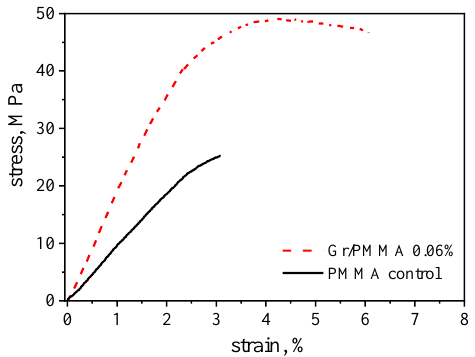
Figure 3. Representative stress–strain curve of the Gr-PMMA nanolaminate (red dotted line) and of the control PMMA sample (black solid line) obtained by uniaxial tensile